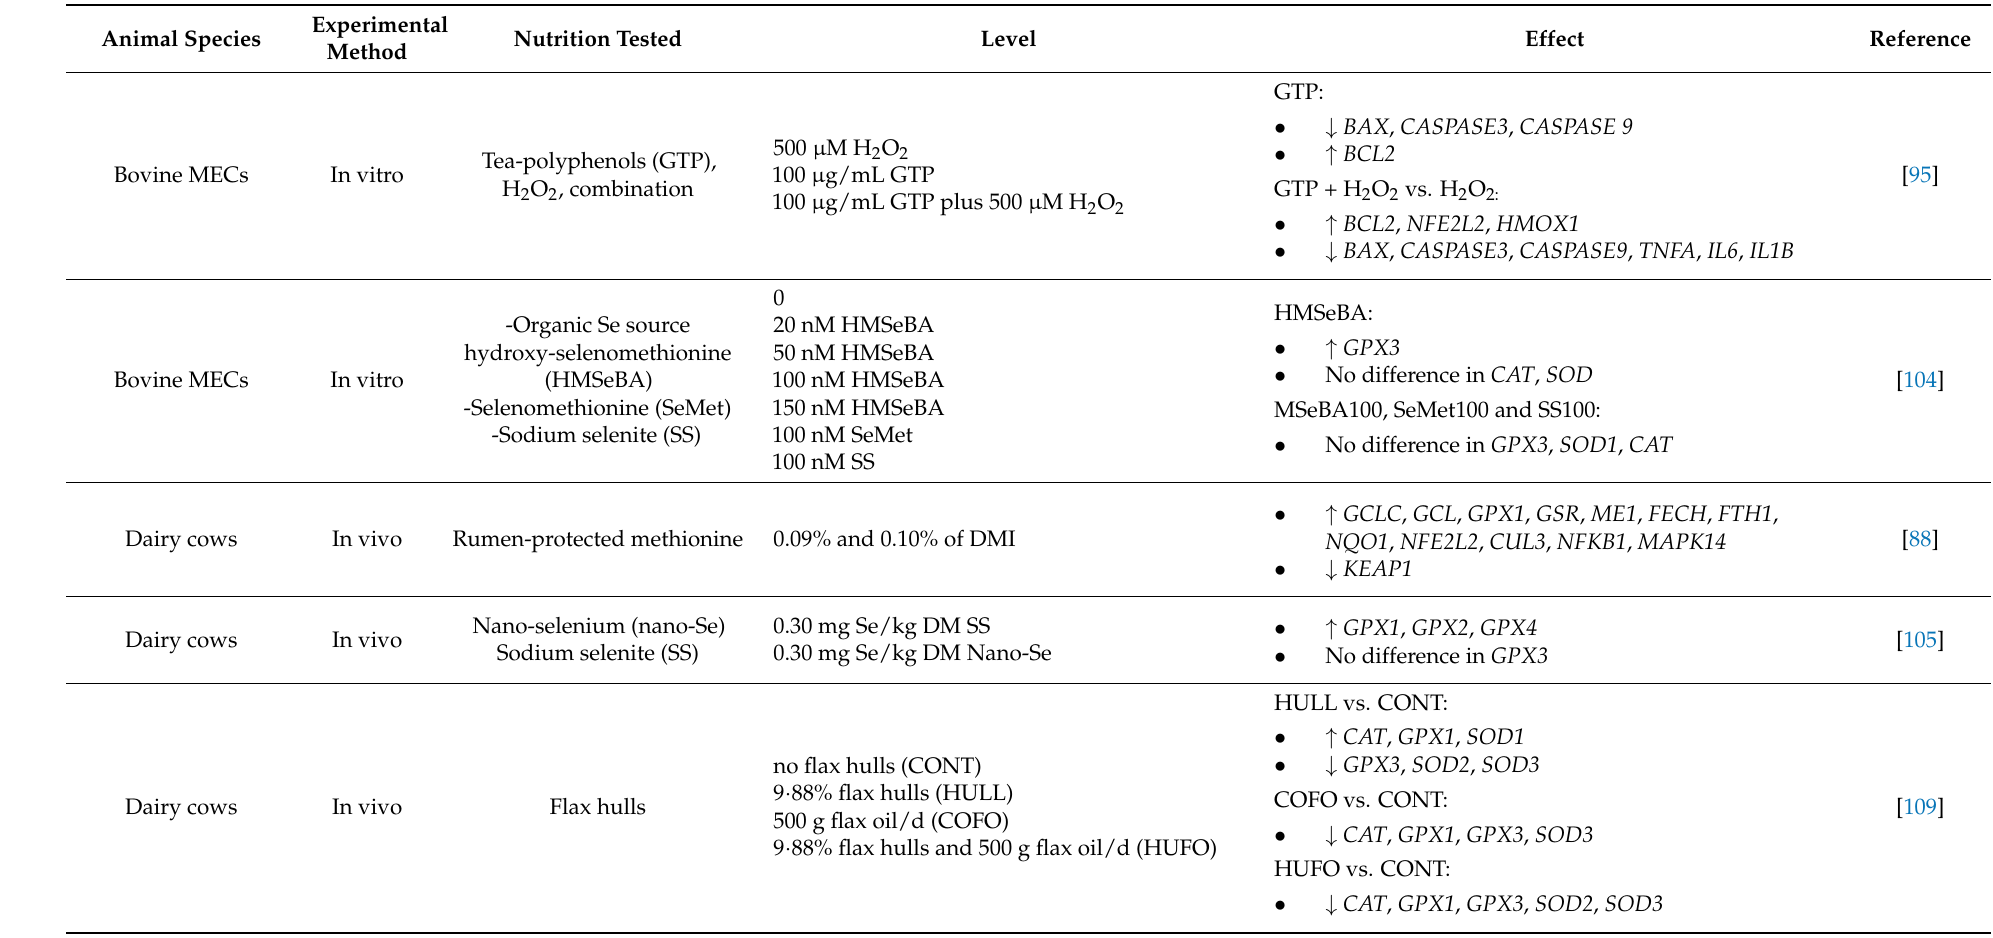
Table 3. Selected studies presenting the impact of bioactive components and feed additives on MECs and the mammary gland gene